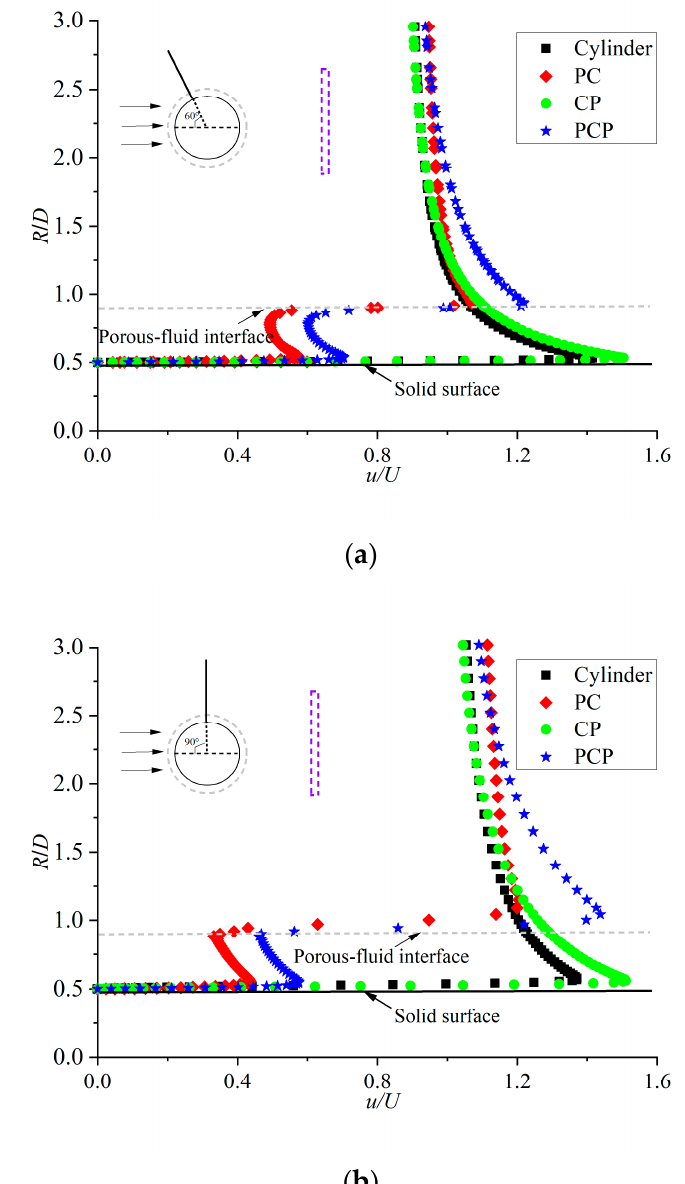
Figure 8. Time-averaged x-component shear stress on cylinder